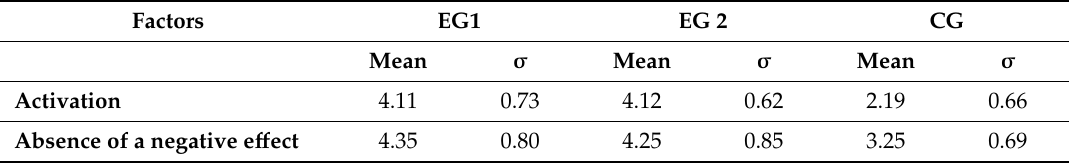
Table 3. Descriptive analysis of the di ff erent groups participating in the